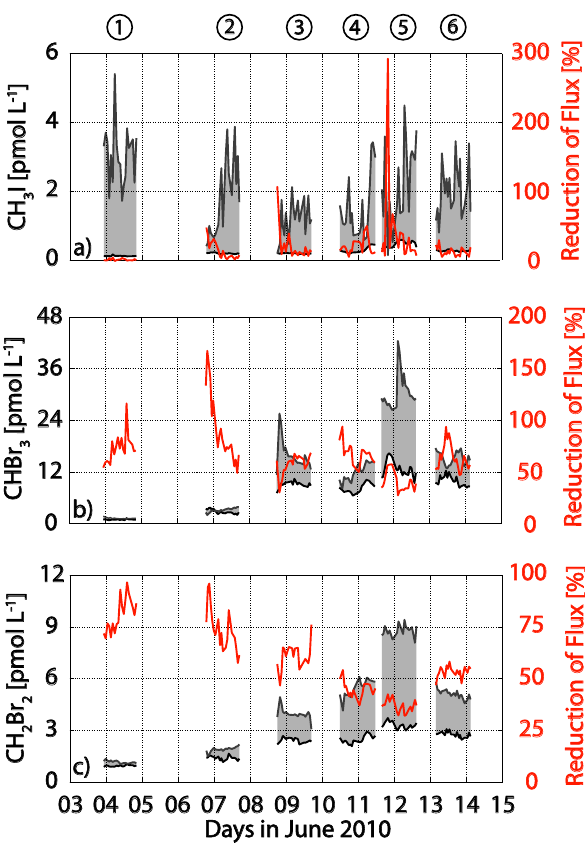
Fig. 6. Influence of atmospheric mixing ratios on the amount of oceanic halocarbons emitted for CH 3 I (a) , CHBr 3 (b) , and CH 2 Br 2 (c) . Oceanic concentrations are plotted in grey (left axis), the equilibrium concentration is delineated in black, and the con- centration gradient is shaded in grey. The percentaged reduction of the concentration gradient by the equilibrium concentration (flux reducing effect) derived from the atmospheric measurements (equi- librium concentration in percent in relation to the water concentra- tions) is shown in red (right axis). Values above 100% refer to fluxes from the atmosphere into the